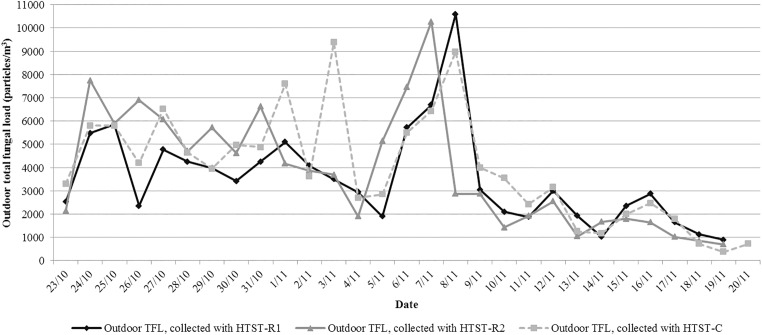
Description of outdoor total fungal loads loads sampled by HTST-O1, -O2 and–C.NOTE: HTST: Hirst-type spore trap. O1 and O2: placed outdoor, above the entrance porch of the transplant unit building (HTST-O1) and on the roof of the infection control building (HTST-O2). C: control, placed outdoor, outside the hospital, 5 km away, in a residential area. The differences between the median total fungal load between HTST-O1, -O2 and -C were not statistically significant (HTST-O1 vs. O2: P = 0.6, O2 vs. C: P = 0.6, O1 vs. C: P = 0.3, with Wilcoxon’s paired signed-rank test using Hochberg’s procedure).